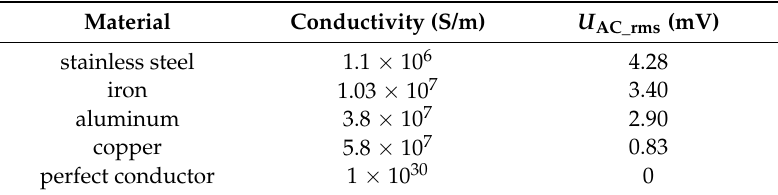
Table 3. U AC_rms obtained by setting different shell materials.